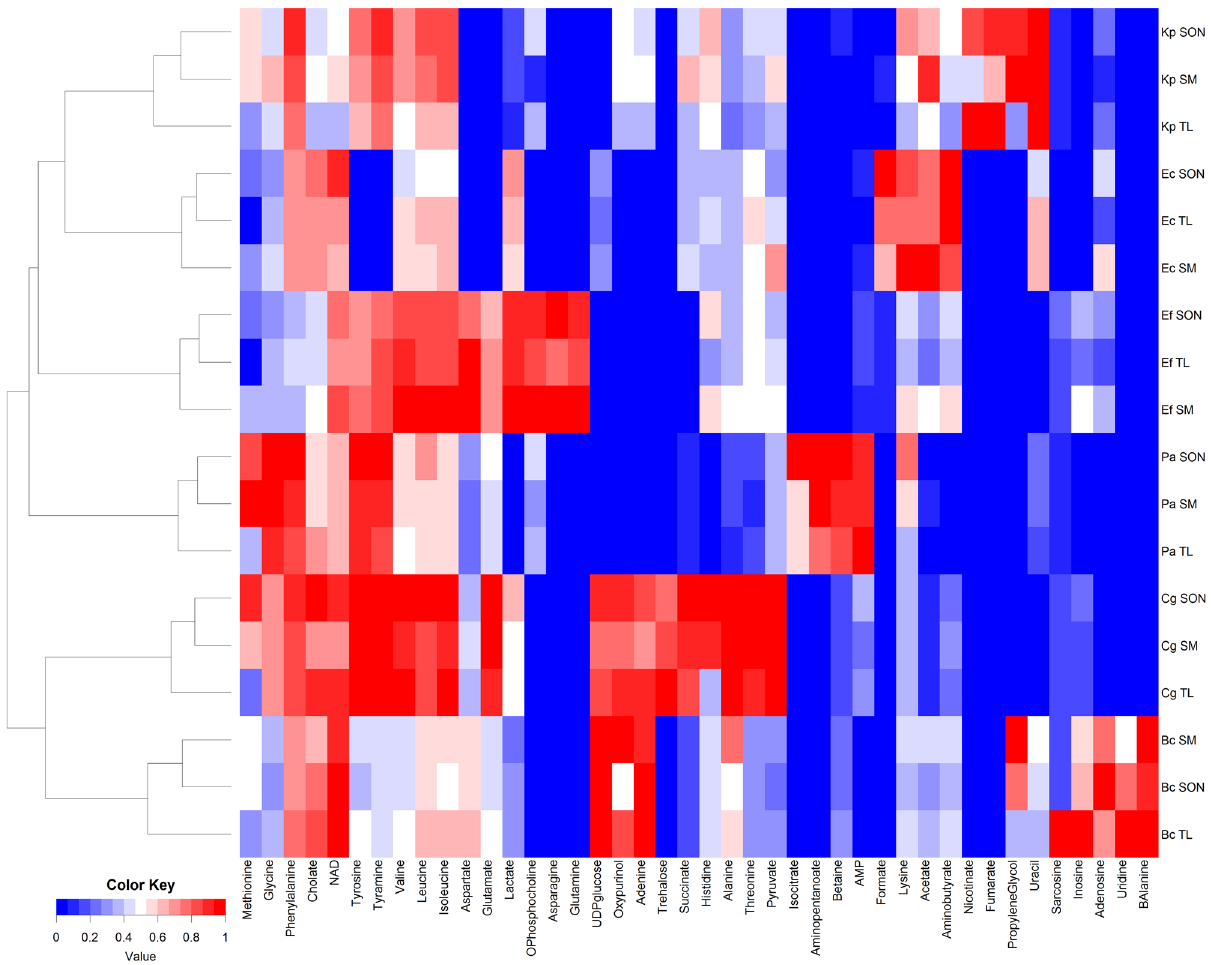
Figure 3. Heat-map comparing the average concentration of metabolites. The heat map was generated by hierarchical clustering analysis (HCA) of all identified metabolites. Red color represents high metabolite concentration and intense blue color represents very low metabolite concentration or metabolite absence (SM— sand mill; TL—tissue lyser; SON—sonication; BC— B. cereus ; CG— C. glutamicum ; EF— E. feacalis ; EC— E. coli ; KP— K. pneumoniae ; PA— P. aeruginosa